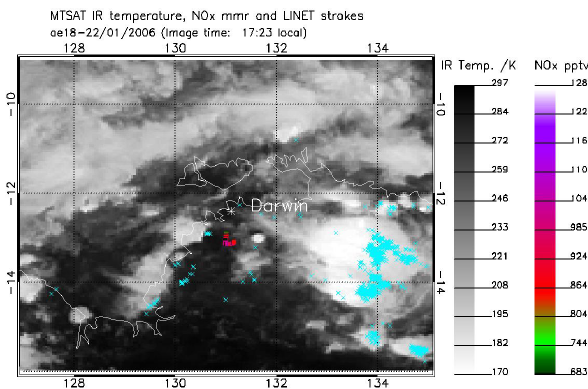
799 Figure 5. Egrett's second cloud­free transect (coloured trace) colour­coded to NO x and 800 Fig. 5. Egrett’s second cloud-free transect (coloured trace) colour- LINET strokes (blue crosses)between 14:05 and 17:11 LT (the sampled storm’s 801 electrically active period)on 22 January 2006.The transect occurred between 17:03 and 802 coded to NO x and LINET strokes (blue crosses) between 14:05 and 17:13 LT. 803 17:11LT (the sampled storm’s electrically active period) on 22 Jan- 804 805 uary 2006.The transect occurred between 17:03 and